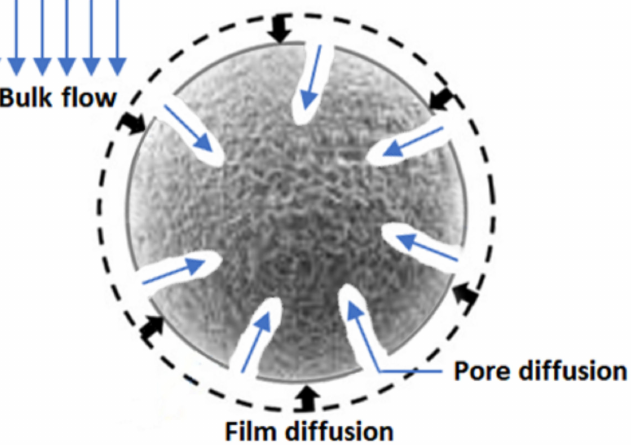
Figure 1. Mechanism of solute diffusion to porous matrix (the self-developed concept was adopted from Ghosh, 2002 [41], Charcosset, 1998